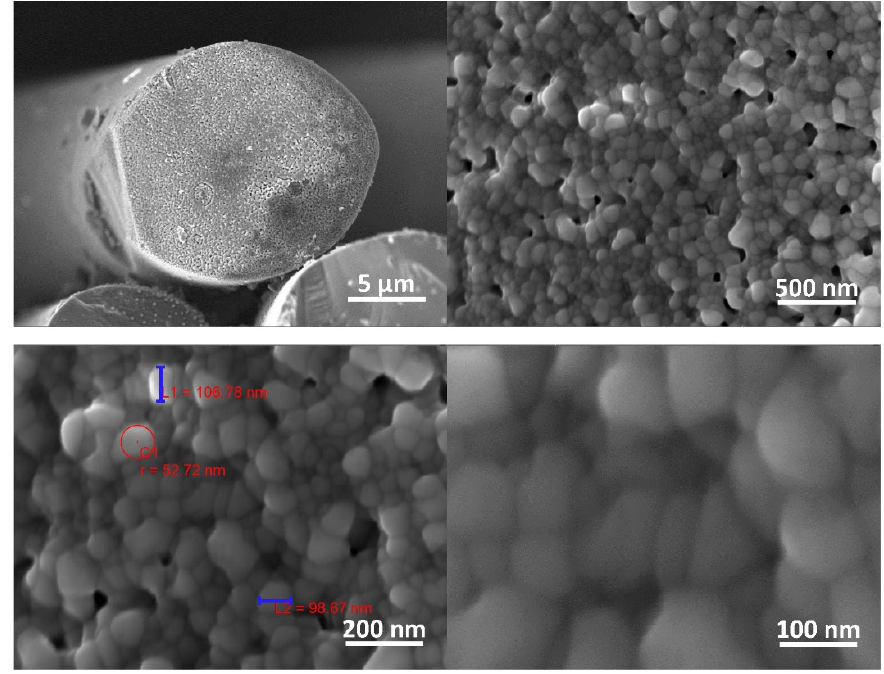
Figure 8. SEM ‐ images of the SiC fiber under various magnifications. Figure 8. SEM-images of the SiC fiber under various magnifications.